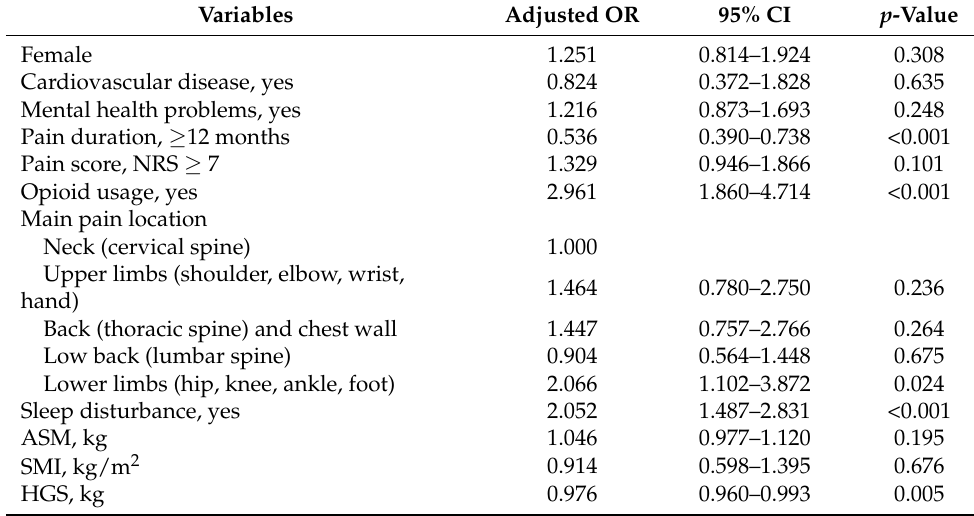
Table 3. Factors associated with neuropathic-like pain symptoms (painDETECT score ≥ 13) in patients with chronic musculoskeletal pain: results from multivariate logistic regression